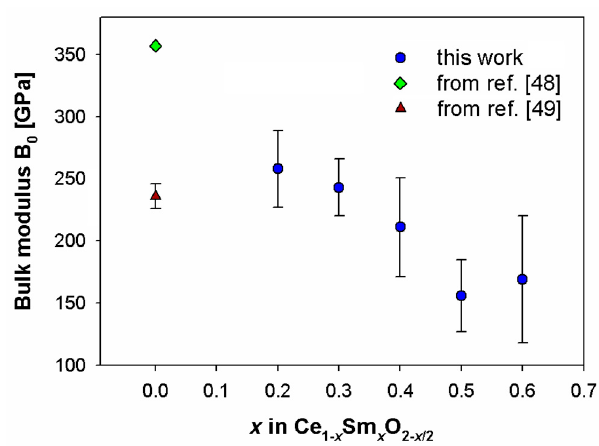
Figure 6. Zero-pressure bulk modulus ( B 0 ) as a function of the Sm content alongside literature data for CeO 2